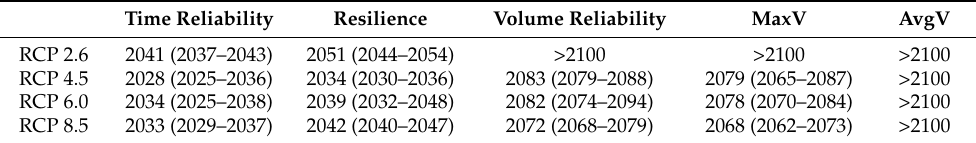
Table 3. First year in which, for each RCP and performance index, the 50th percentile reservoir perfor- mance exceeds a 10% worse-than-the-reference value without going back. In parenthesis are the same result, but for the 10% and 90% of error estimated with the bootstrapping (Supplementary